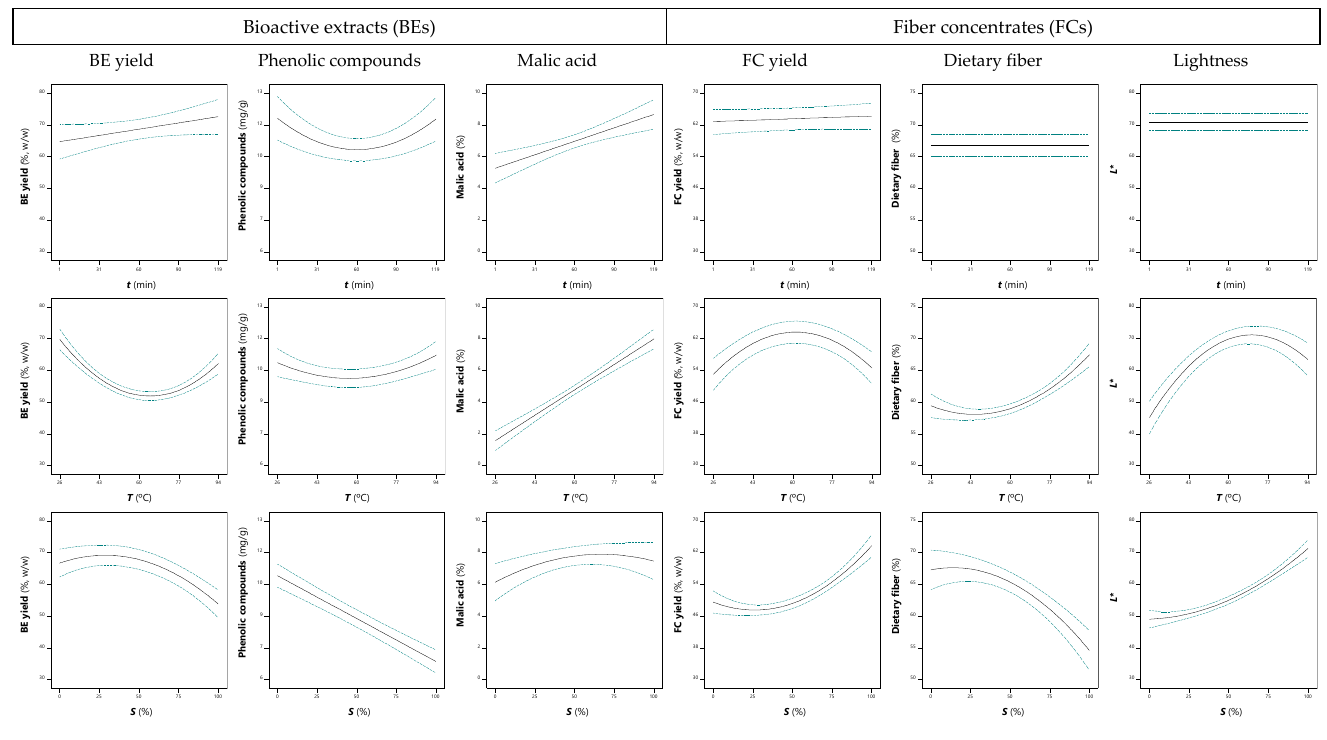
Figure 4. Response plots for the effects of each independent variable on extraction yields, phenolic compounds, and malic acid content of bioactive extracts (BEs), and dietary fiber content and lightness of fiber concentrates (FCs) obtained from quince peel. In each 2D plot, the unplotted independent variables were kept constant at their optimum shown in Table S5.